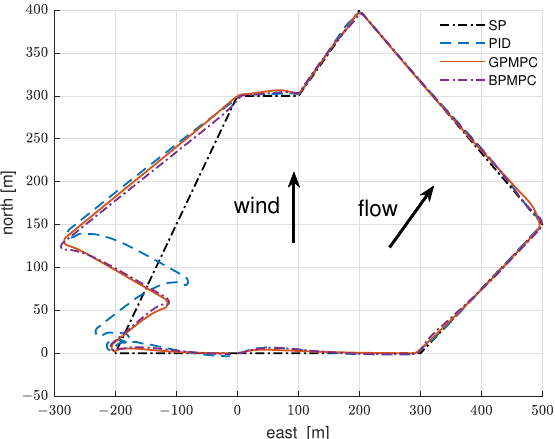
Figure 23. Sailing trajectory with current disturbance. The black dotted line is the reference trajectory, the blue dashed line is the PID control, the purple dotted line is the BPMPC control effect, and the orange solid line is the GPMPC control.